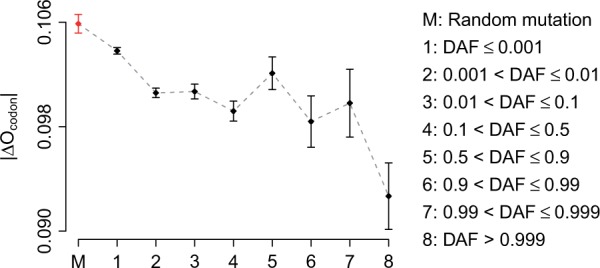
Change in codon optimality (|ΔOcodon|) as a function of DAF. Each point represents the mean of the corresponding category. Error bars indicate the standard error of the mean.